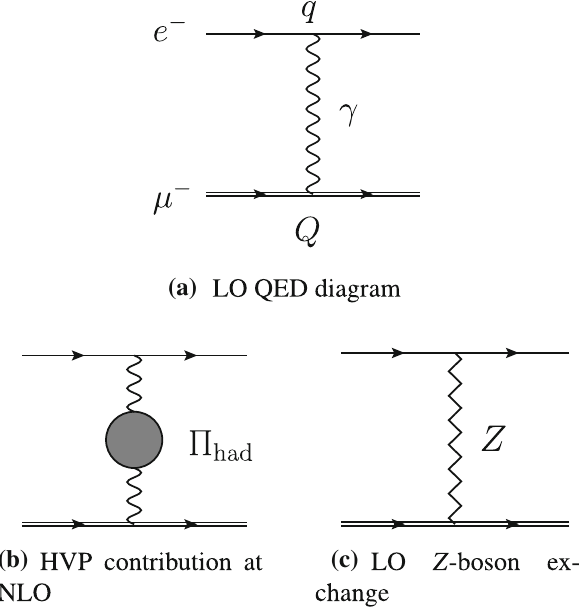
Fig. 3 LO contributions from QED, HVP and the Z -boson exchange